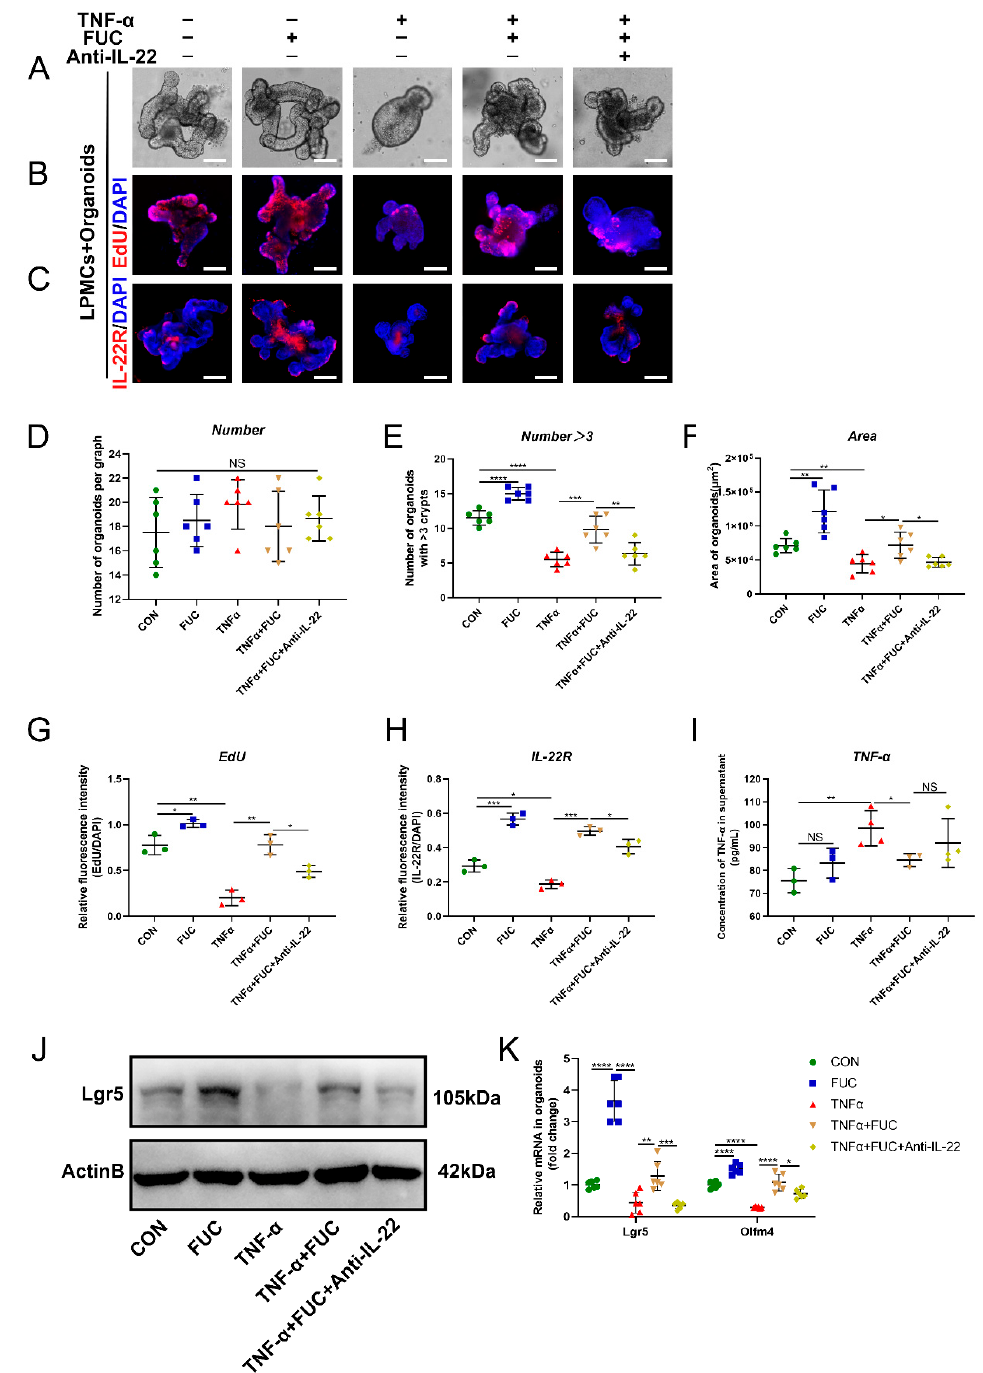
Figure 8. Restoration of TNF- α -induced ISC damage through IL-22 after L-fucose treatment. ( A ) Representative images of organoids under a light microscope (scale bar, 100 µ m). ( B ) Representative images of EdU (red) staining of organoids (scale bar, 100 µ m). ( C ) Representative images of IL-22R (red) immunofluorescence in organoids (scale bar, 100 µ m). ( D ) Number of organoids per field of view. ( E ) Number of organoids with more than 3 buds per graph. ( F ) Average area of organoids per graph. Quantitative analysis of ( G ) EdU and ( H ) IL-22R fluorescence intensity in organoids. ( I ) ELISA analysis of TNF- α in the culture supernatant of the LPMC-organoid coculture system. ( J ) Western blotting analysis of Lgr5 protein in organoids. ( K ) qRT-PCR analysis of Lgr5 and Olfm4 in organoids. Data are expressed as the mean ± SD. * p < 0.05, ** p < 0.01, *** p < 0.001, **** p < 0.0001; NS, no significance. +, with. − ,